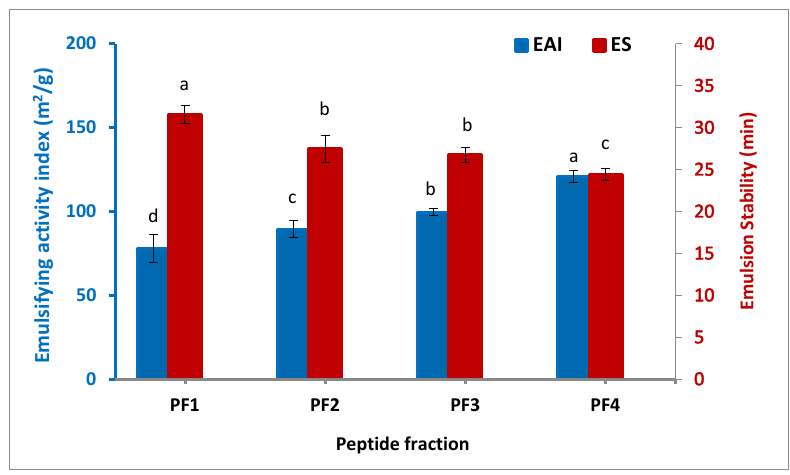
Figure 2. Emulsifying activity index and stability of the isolated peptide fractions. Results are illustrated as means ± SD and values within each variable with the different letters are significantly different ( p < 0.05).